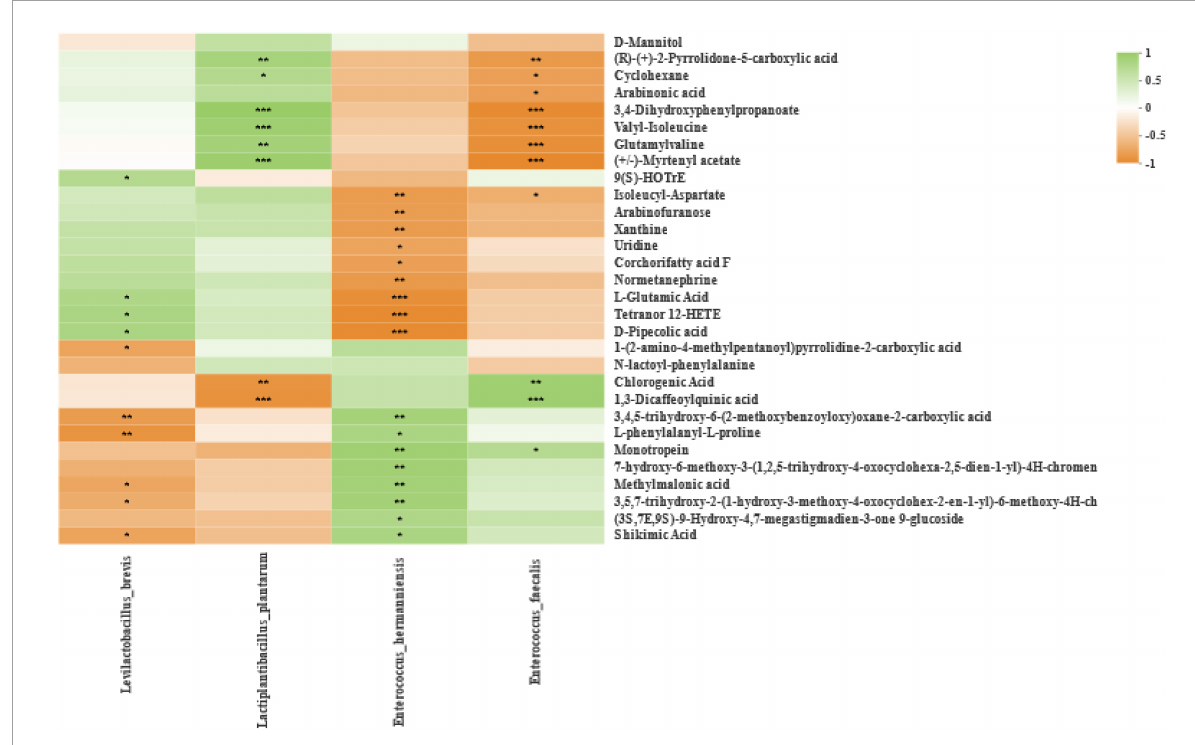
acid, which is consistent with the report of Li et al.